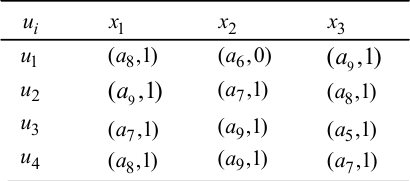
Table 7. Normalized reference information of Table 3 Table 8. Normalized reference information of Table